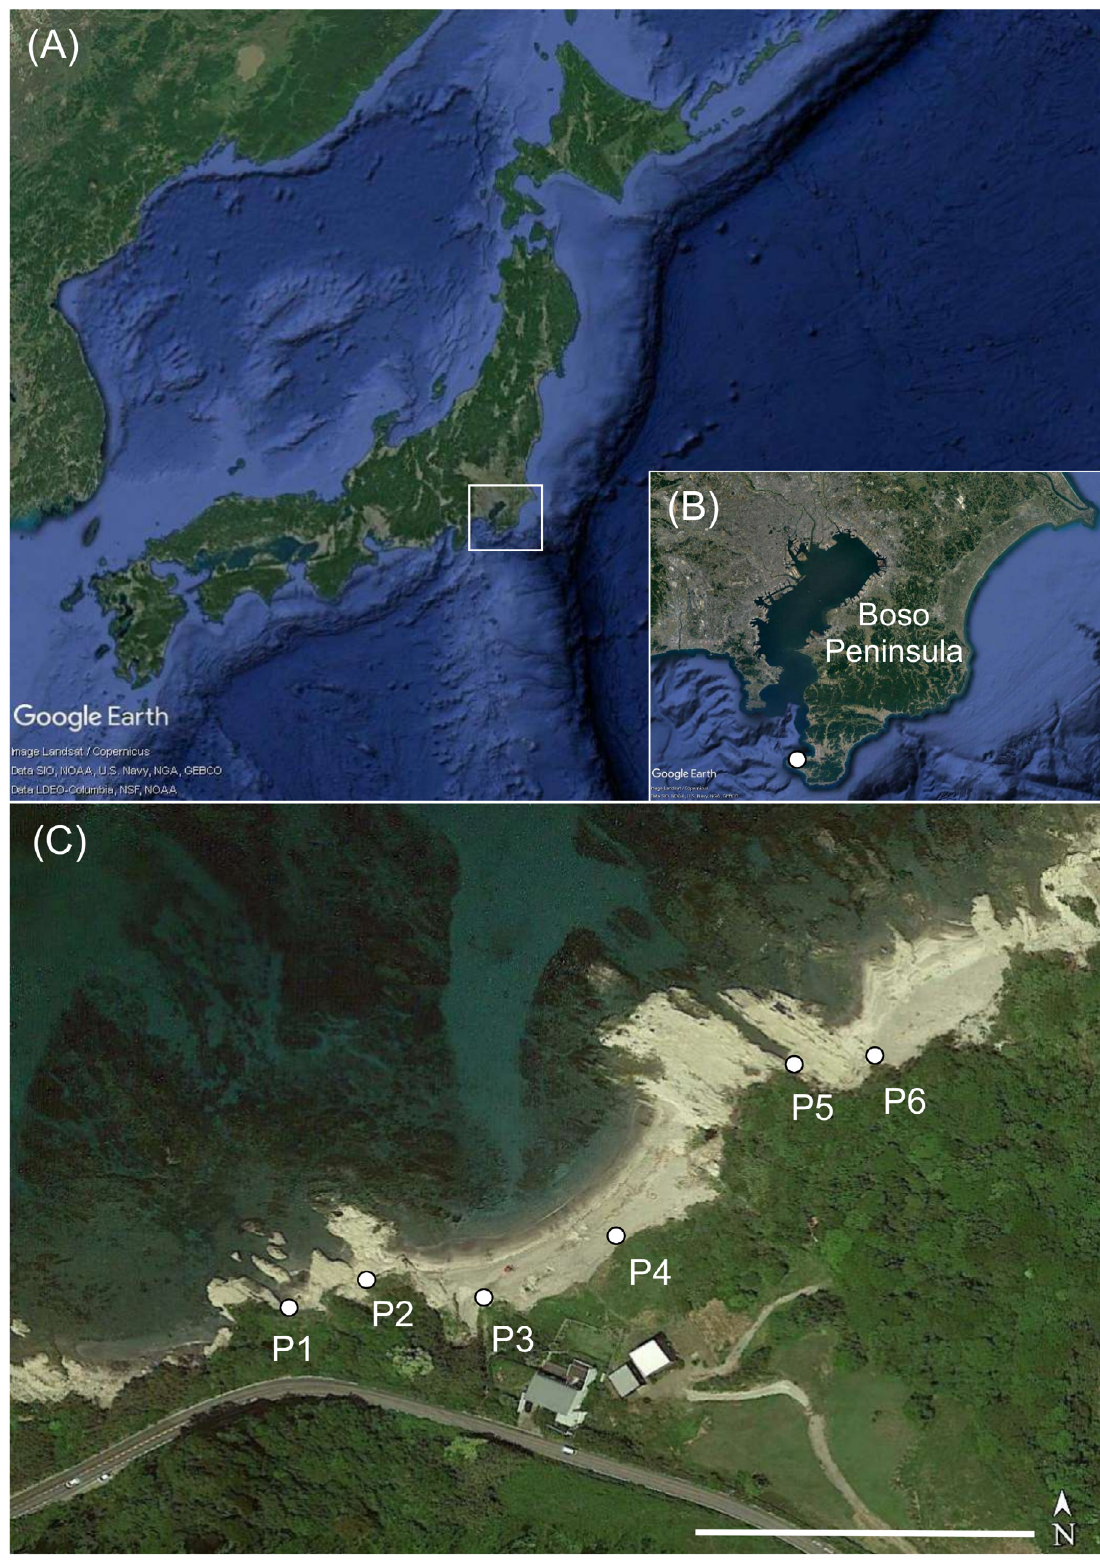
Figure 1. Google Earth photographs showing the Japanese Archipelago (A), Boso Peninsula (B), and survey points at which early juveniles of land hermit crabs were investigated at the small beach of Banda (34°58’N, 139°46’E), Chiba Prefecture, Japan (C). The white rectangle in panel (A) indicates the area including the Boso Peninsula. The white circle in panel (B) indicates the survey site at Banda. The six survey points (P1–P6) at the small beach are shown in panel (C). Horizontal white line in panel (C) is a scale bar (100